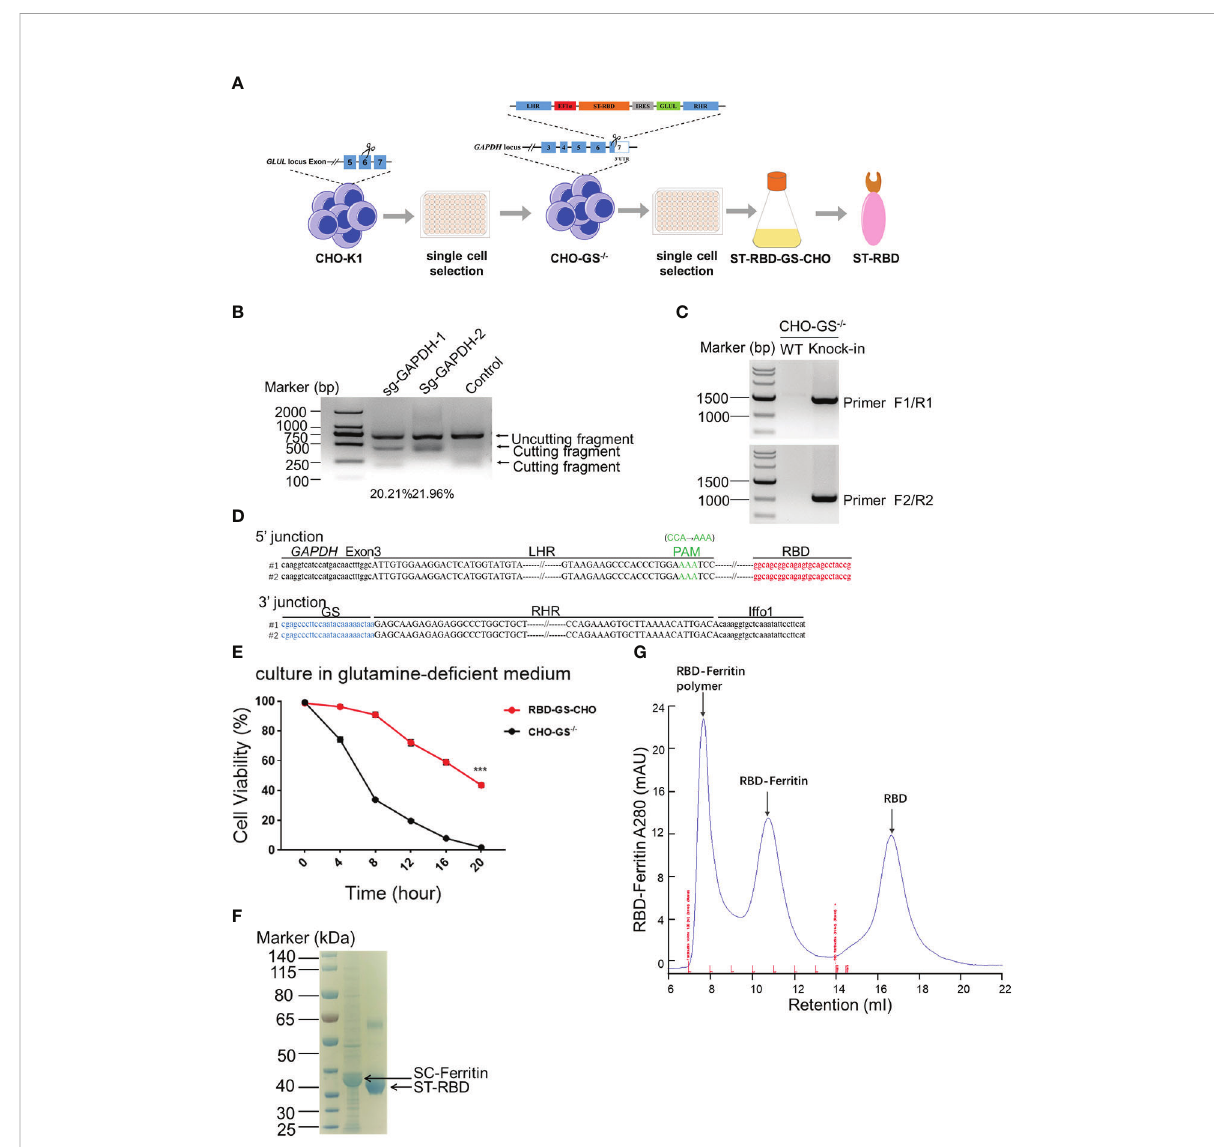
FIGURE 1 Construction of CHO-GS cells stably expressing RBD protein using CRISPR/Cas9 system for the assembly of the SARS-CoV-2 RBD NP Vaccine. (A) ST-RBD-GS-CHO cell construction strategy: CHO-K1 cells were transfected with Cas9/sgRNA targeting the GLUL gene, and 24 hours later, CHO-GS-/- cells were screened with puromycin for 3 days and subjected to single-cell screening with ampli fi cation. The ST-RBD-GS gene was then knocked into the GAPDH locus by the CRISPR/Cas9 system to consecutively express the RBD protein. (B) CHO-GS-/- cells were transfected with Cas9/sgRNA and donor DNA targeting the GAPDH gene by IDLV infection, and the editing ef fi ciency of sgRNA was detected by the T7E1 assay as previously. Negative control was an unrelated sgRNAs. (C, D) Single cells were seeded and ampli fi ed, and then genomic DNA was extracted and ampli fi ed by PCR using primers F1/R1 and F2/R2, primer sites were shown in Figure 1A, respectively. The negative control was CHO-GS-/- cells. C: PCR ampli fi cation of fragments to con fi rm the insertion; D: blast results for DNA sequencing. (E) . Cell viability of CHO- GS-/- and RBD-GS-CHO cells was determined by CCK-8 assay in the glutamine-free medium. (F) 10 m g of puri fi ed ST-RBD and SC-ferritin samples were analyzed by SDS-PAGE electrophoresis and stained with Coomassie Blue. (G) Puri fi cation and concentration of RBD-Ferritin nanoparticles by size exclusion chromatography. The UV absorption value at 280 nm indicates the abundance of protein molecules. The X-axis indicated the retention volume. All the experiments were performed at least 3 times